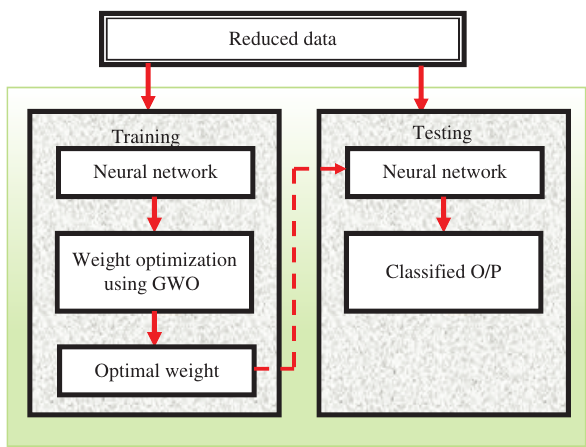
Figure 3: Overall Process of the